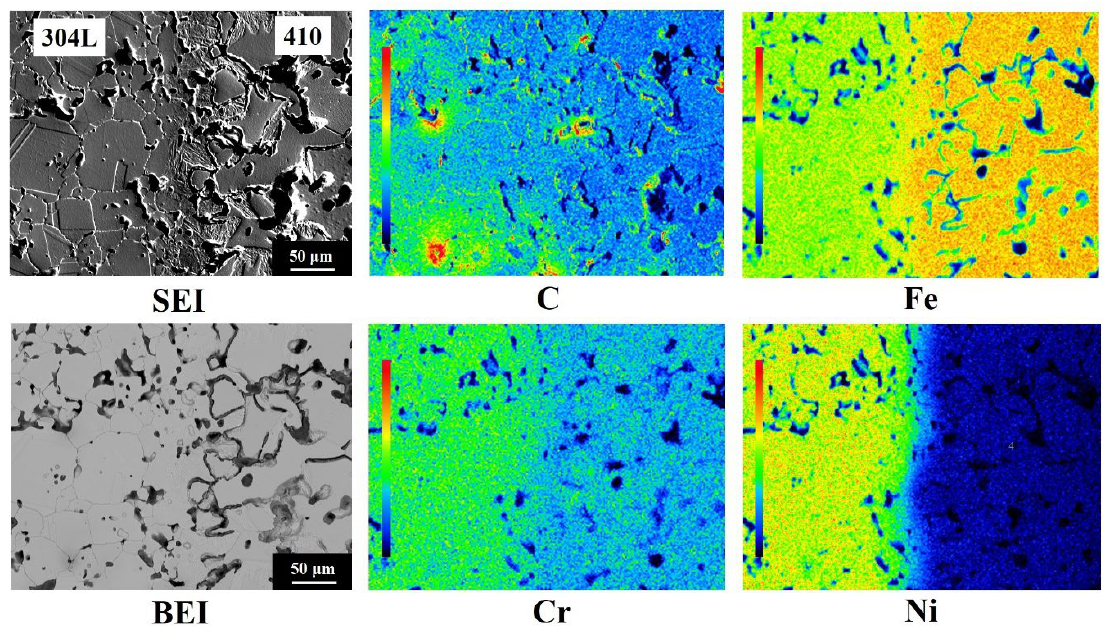
Figure 6. EPMA elemental distributions at the interface of the 410/304L LMCs.